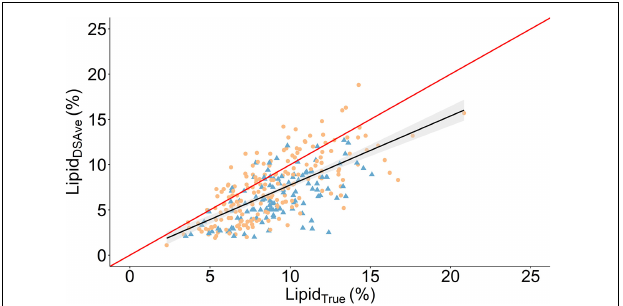
FIGURE 2 | Scatter plot of the relationship between the mean fillet lipid percentage of four measurements using a handheld dielectric spectrometer (Lipid DSAve ) and the laboratory reference method (Lipid True ). A linear regression is given as the solid black line with the 95% confidence interval is gray shading. The solid red line is the line of unity. Round orange points denote 2017 cohort and triangle blue points are the 2016 cohort.